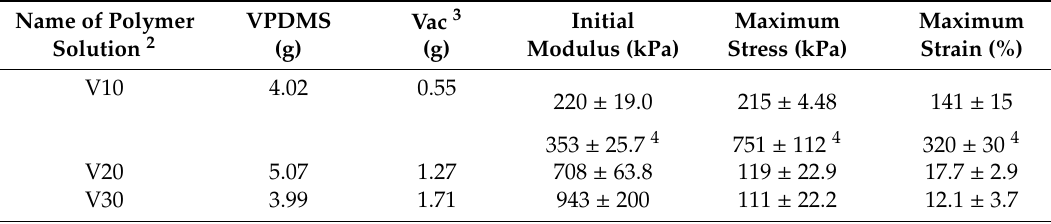
Table 1. Composition of VPDMS solutions in VAc and mechanical properties 1 of the UV-cured films prepared from the solution layers.